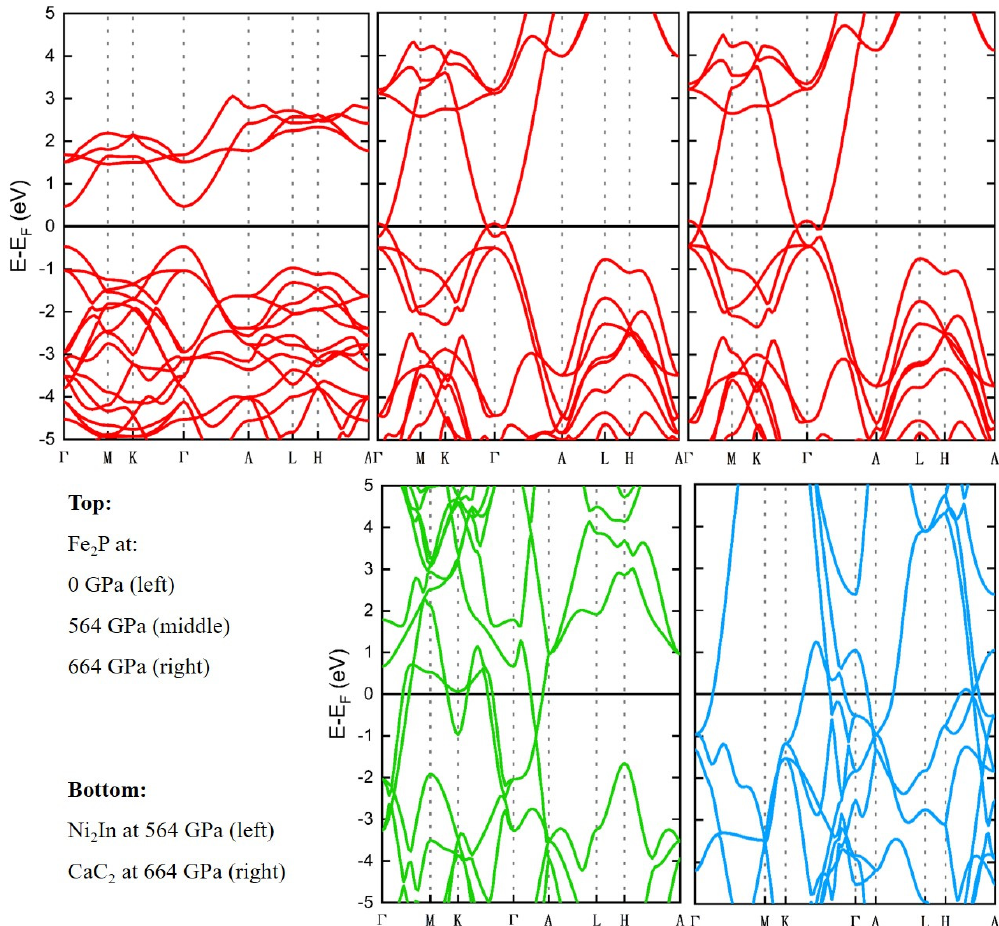
Figure 5. Electronic band structure for: ( Top ) the Fe 2 P phase at 0 GPa, 564 GPa, and 664 GPa; ( Bottom ) the Ni 2 In and CaC 2 phases at 564 GPa and 664 GPa, respectively.